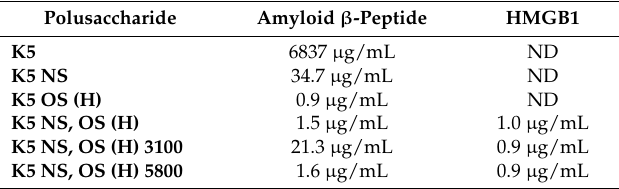
Table 1. Sulphated K5 polysaccharides inhibit receptor for advanced glycation end products (RAGE)–ligand binding. Binding of soluble biotinylated ligands to full length extracellular human RAGE (sRAGE) coated plastic microwells was analysed as described in materials and methods. Representative IC50 values are shown. NS = N-sulphated, OS = O-sulphated, OS(H) = highly O-sulphated, 3100 = size of 3100 Da, 5800 = size of 5800 Da. ND = not determined.